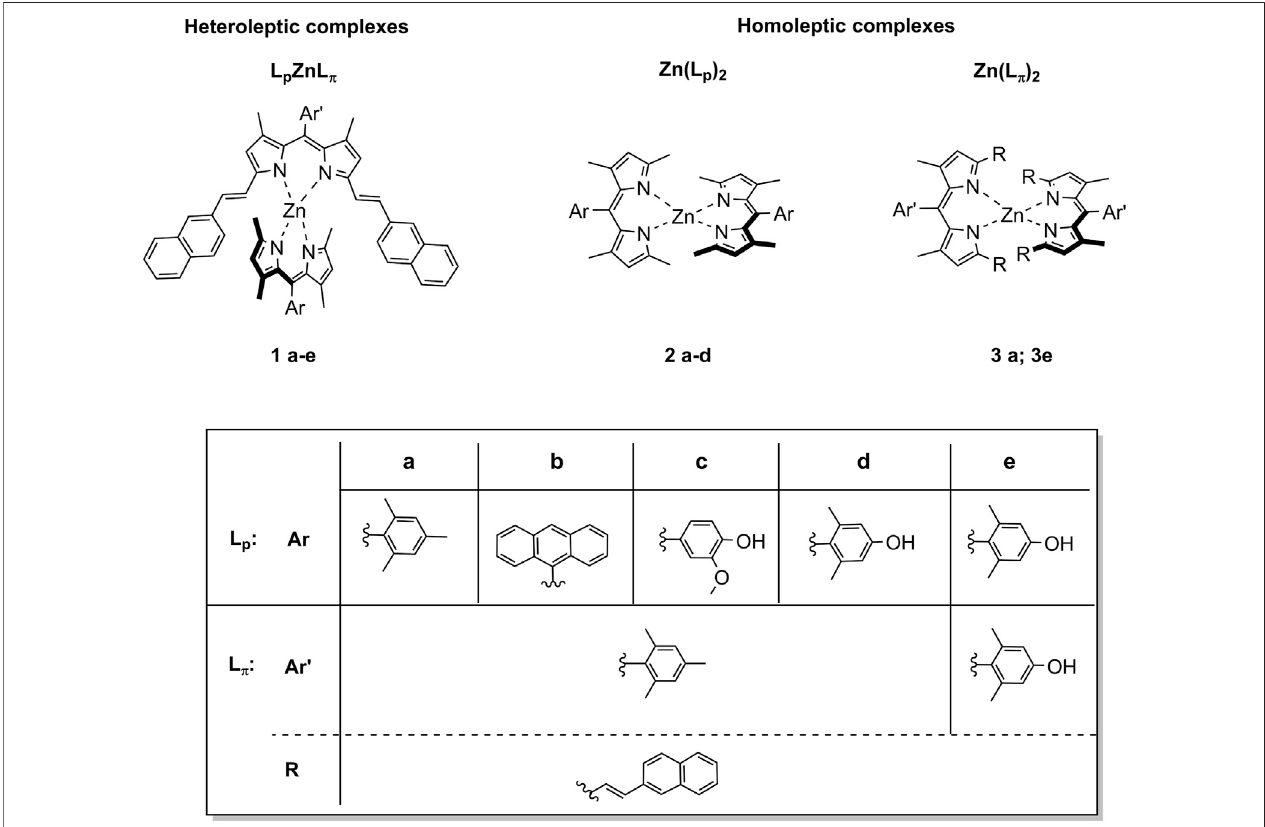
FIGURE 1 | Chemical structures of the new heteroleptic Zn bis(dipyrrinato) complexes 1a-e presented in this work. For comparison we reported also the study of the homoleptic complexes of type Zn (L p ) 2 2a-d and of type Zn (L π ) 2 3a and 3e .